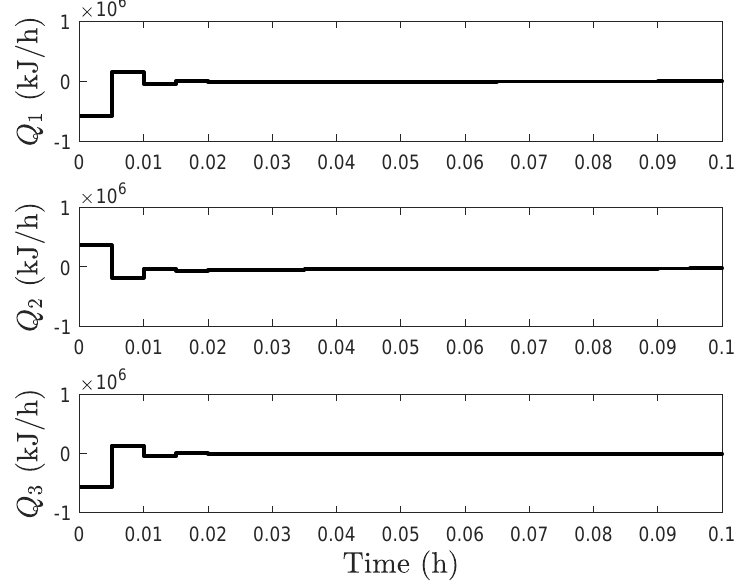
Figure 2. Q 1 , Q 2 , and Q 3 over 0.1 h of operation for the 2 CSTR-flash drum process under an MPC which drives the closed-loop state to the unstable